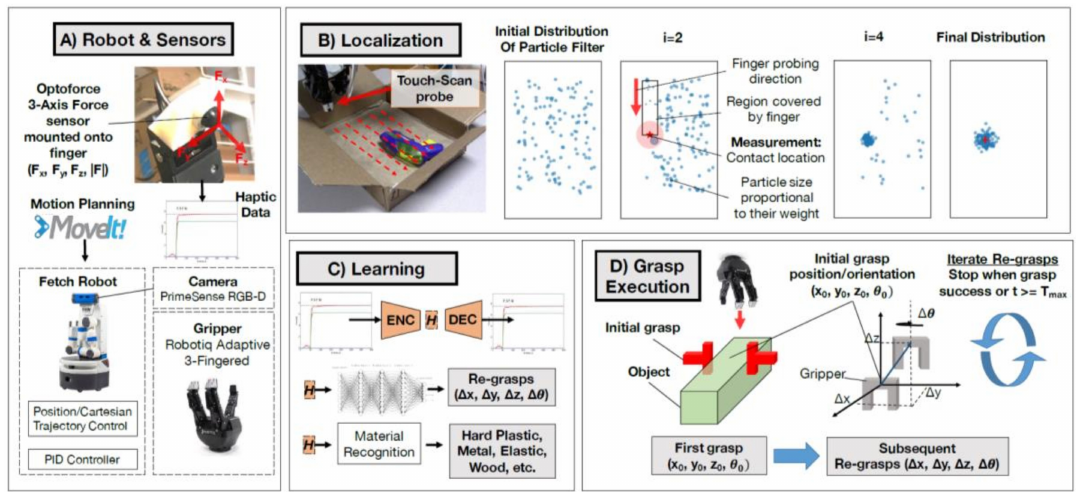
Figure 16. A grasping approach based on sensors and learning networks [134].